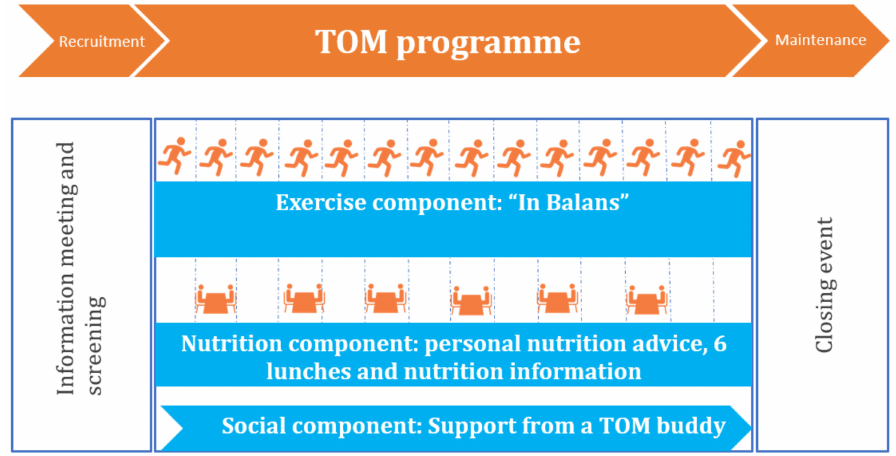
Figure 1. Phases of the “Thuis Onbezorgd Mobiel” (TOM)